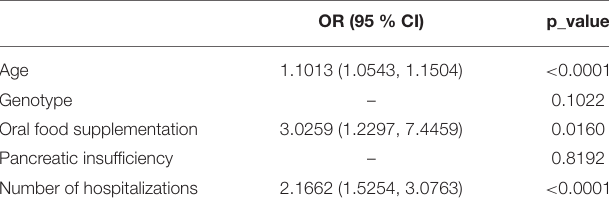
TABLE 5 | Adjusted odds ratios of cystic fibrosis-related diabetes (CFRD) patients’ infection status. OR (95 % CI)